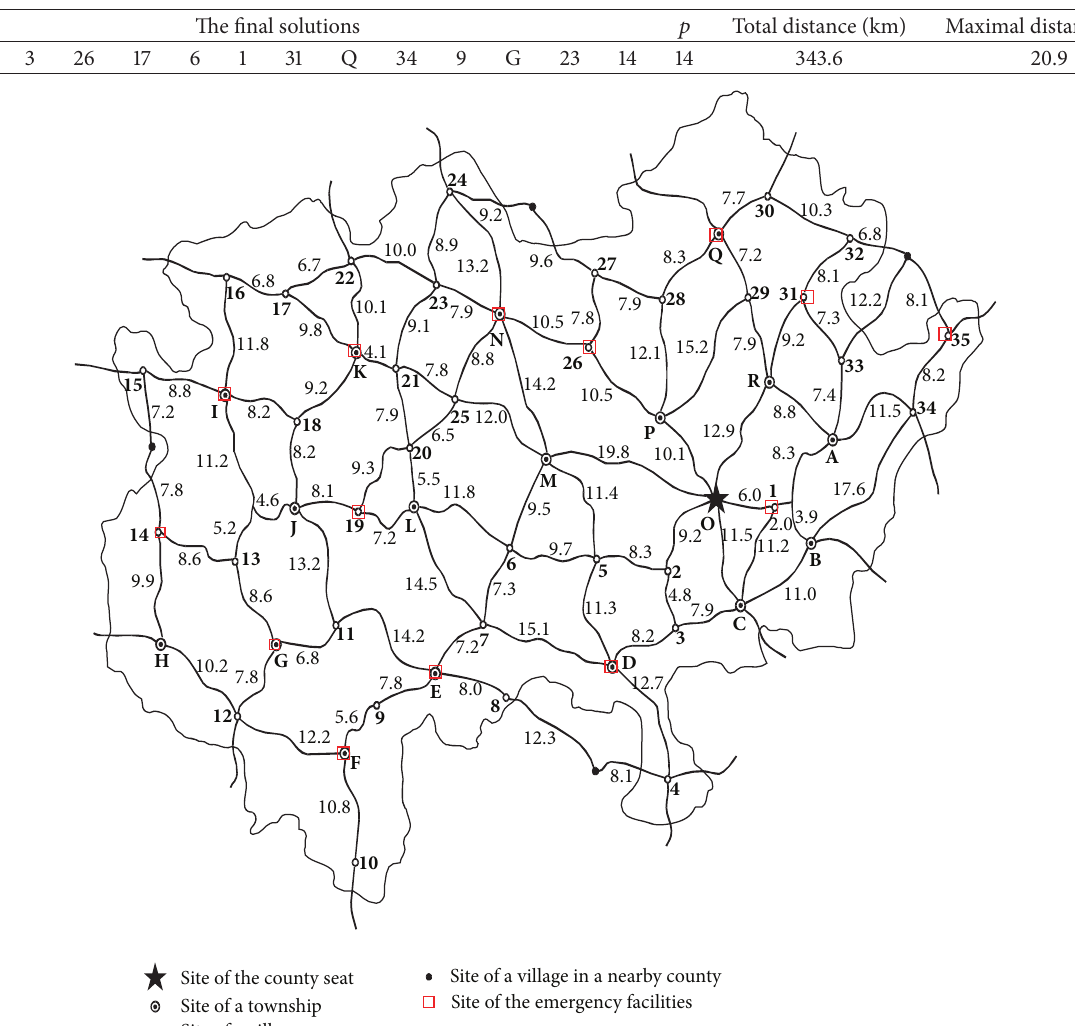
Table 5: The final solutions for the emergency facilities location problem.